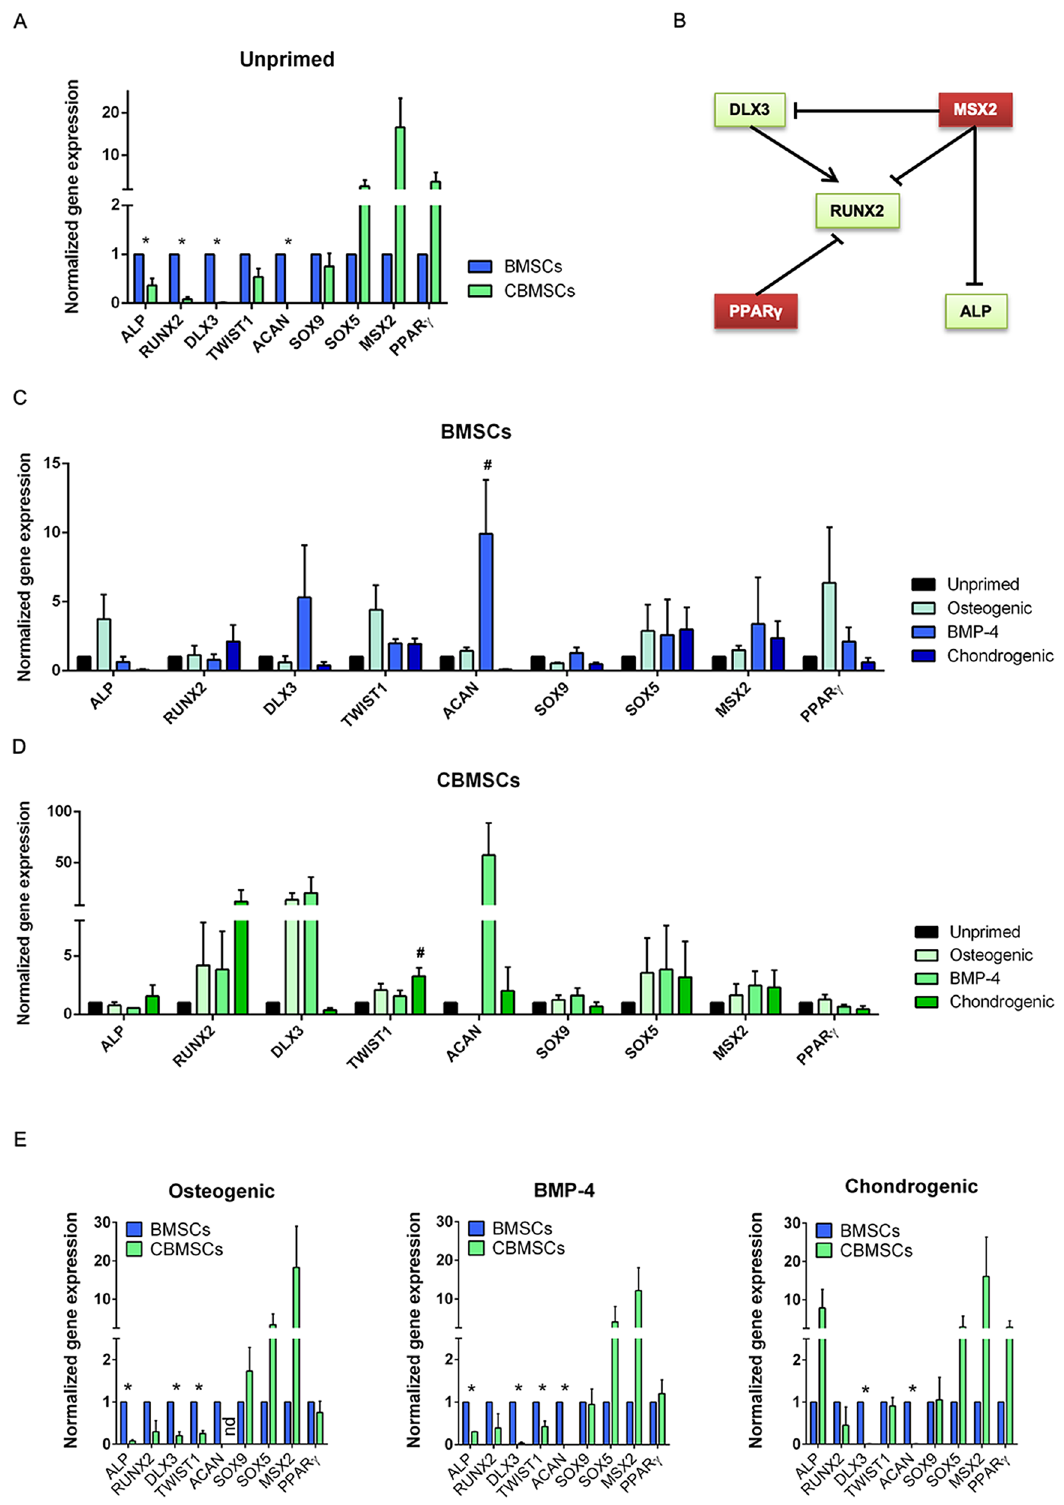
Figure 3. Gene expression profiles of unprimed and primed BMSCs and CBMSCs. ( A ) Histogram showing gene expression of BMSCs and CBMSCs at the steady state; values are represented as Mean ± SEM and normalized to BMSCs. ( B ) Schematic summarizing positive and negative regulations of the gene expression of crucial osteogenic and chondrogenic players. ( C ) Histogram representing transcriptional profile of BMSCs upon different differentiation primings protocols; values are represented as Mean ± SEM and normalized to unprimed BMSCs. ( D ) Histogram representing transcriptional profile of CBMSCs upon different differentiation primings protocols; values are represented as Mean ± SEM and normalized to unprimed CBMSCs. Statistical analysis was by unpaired Student’s t -test for single experimental condition ( A , E ) and by one-way ANOVA followed by Holm–Sidak’s multiple comparison test for multiple experimental conditions ( C , D ). *Significant difference between MSCs of different tissue origin ( A , E ); # significant difference between primed and unprimed MSCs ( C , D